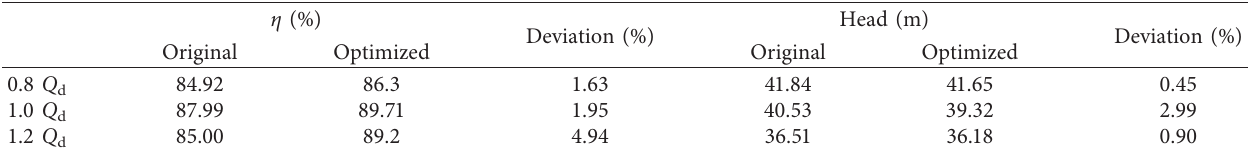
Table 13: Comparison of performance.